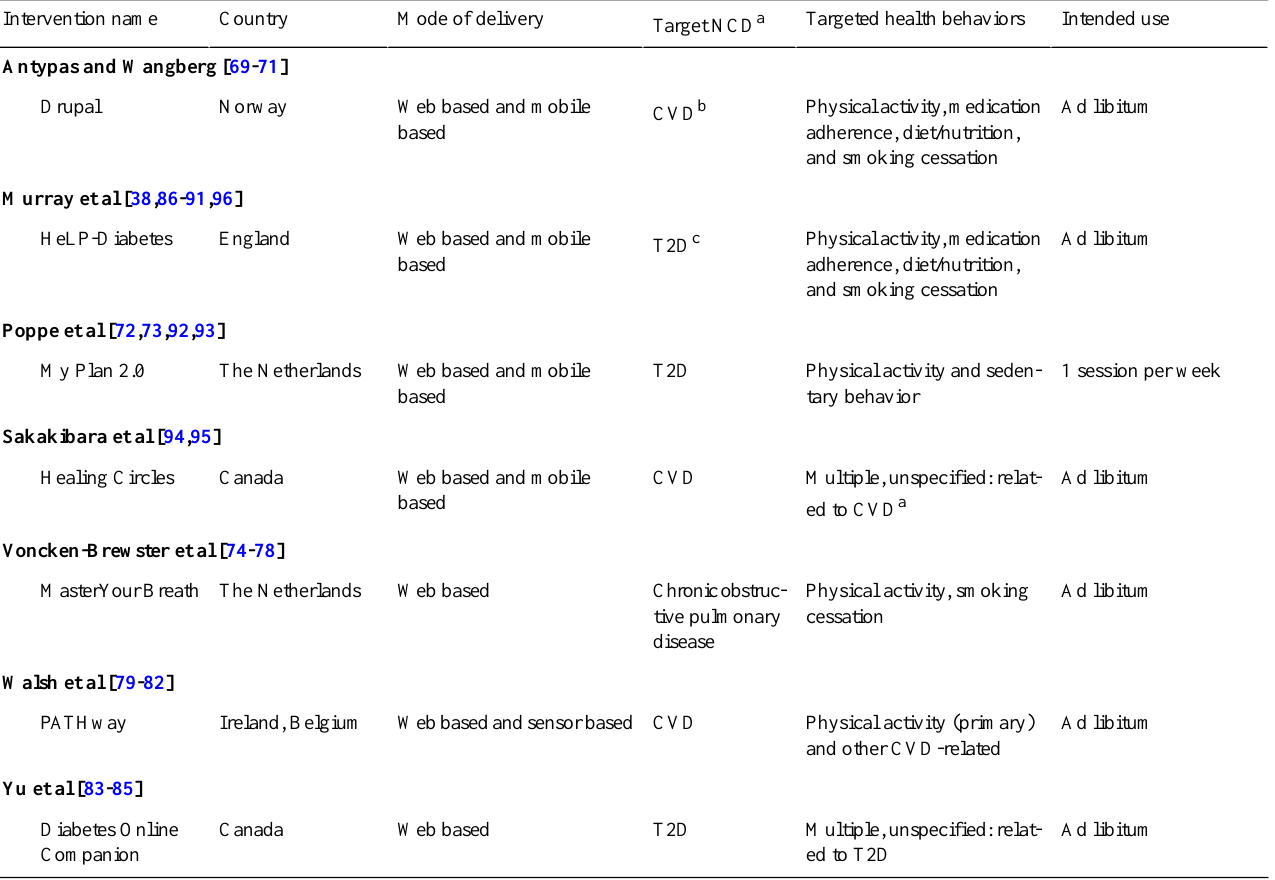
Table 3. Overview of digital platform-like